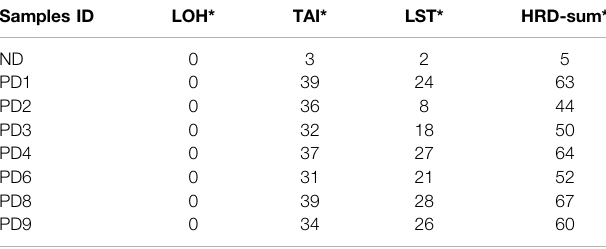
TABLE 1 | HRD-scores of the P1 patient. Samples